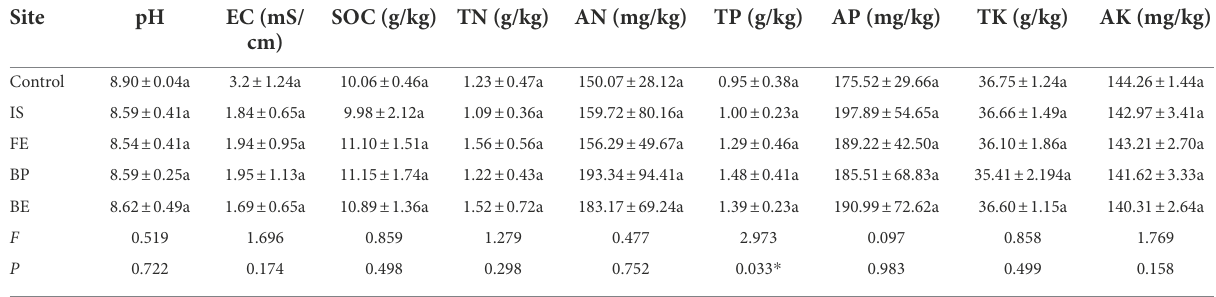
TABLE 3 One-way ANOVA analysis of the effects of PV panels on soil